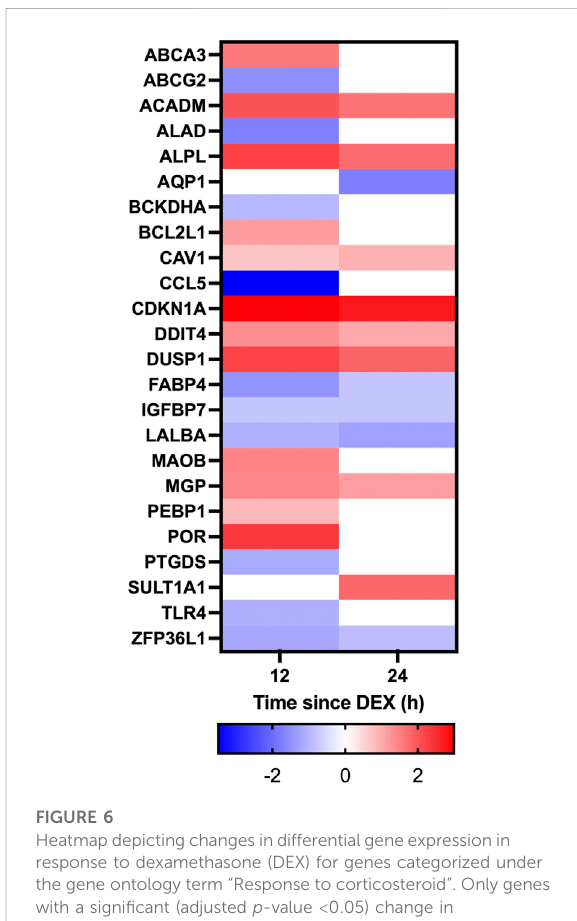
FIGURE 6 Heatmap depicting changes in differential gene expression in response to dexamethasone (DEX) for genes categorized under the gene ontology term “ Response to corticosteroid ” . Only genes with a signi fi cant (adjusted p -value < 0.05) change in expression for either 12 v 0 h (h), or 24 v 0 h, and a log fold change between − 2 and 2 in response to DEX are shown. Geneexpression data is for n = 3 cows.